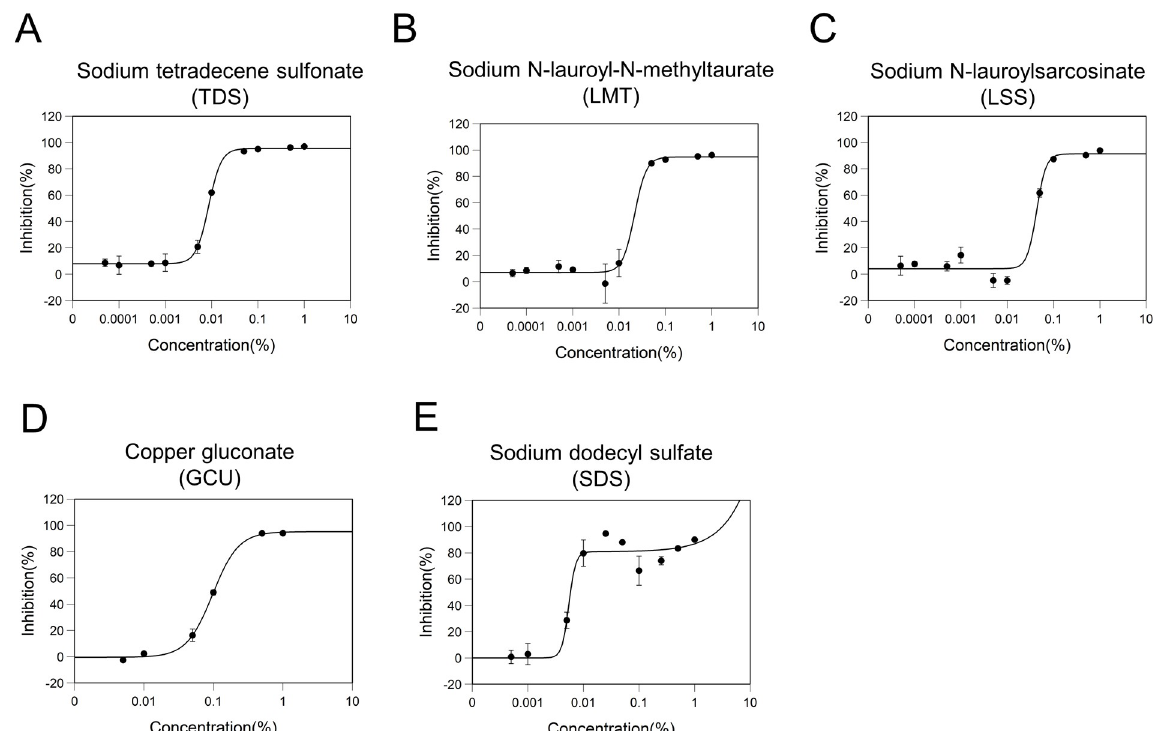
Fig 2. Effect of ingredient concentration on inhibitory effects of the interaction between the spike protein of SARS-CoV-2 and ACE2. The dose-response inhibitory effects of interaction between spike protein of SARS-CoV-2 and ACE2 for (A) Sodium tetradecene sulfonate, (B) Sodium N-lauroyl-N-methyltaurate, (C) Sodium N-lauroylsarcosinate, (D) Copper gluconate, and (E) Sodium dodecyl sulfate are shown. The data were plotted and modeled by a four-parameter Log-logistic fit (A–D) and a four-parameter Brain–Cousens fit (E) to determine the 50% inhibitory concentration (IC50) value. All data points were expressed as the mean ± SD (n = 3).